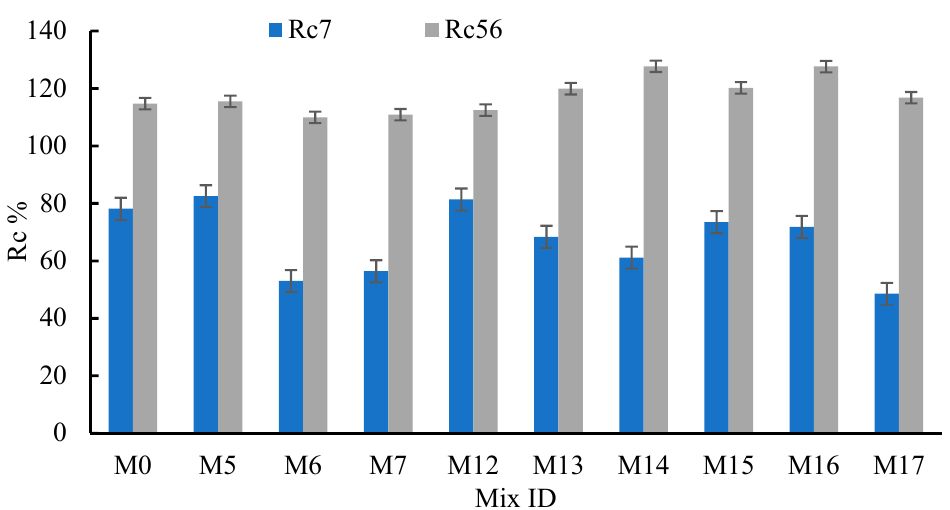
Figure 8. Effects of the RCP, AMF, and SF percentages on Rc7 and Rc56.